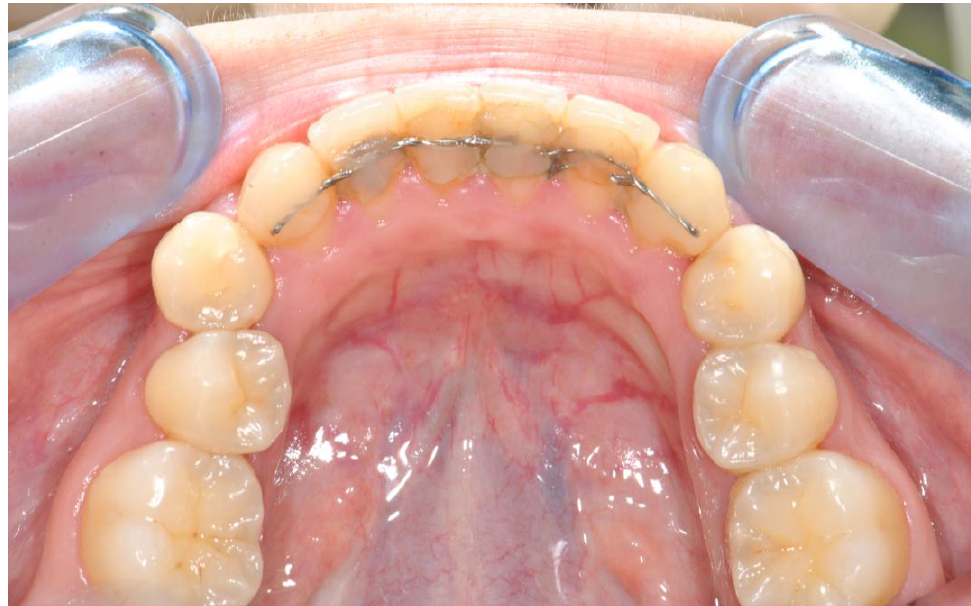
Figure 2. Detached and infiltrated orthodontic fixed retainer.